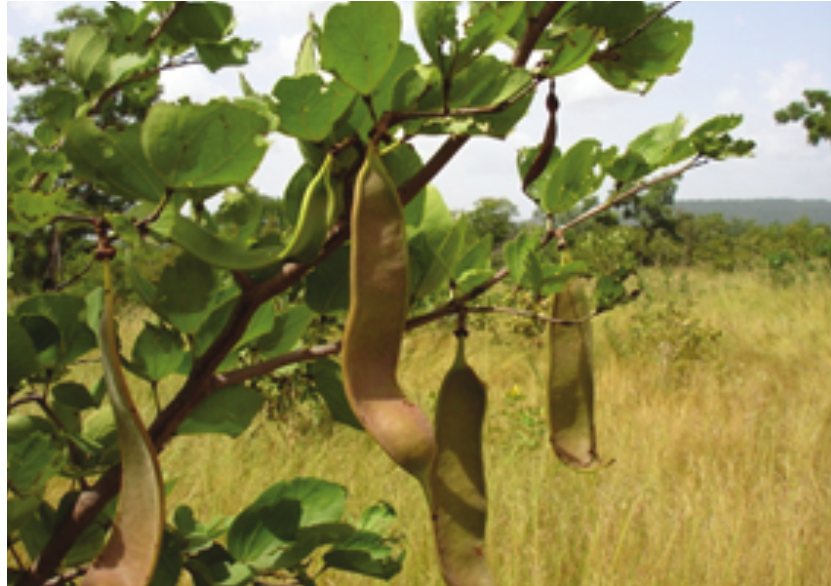
Figure 1: Fruits and leaves of P. reticulatum.